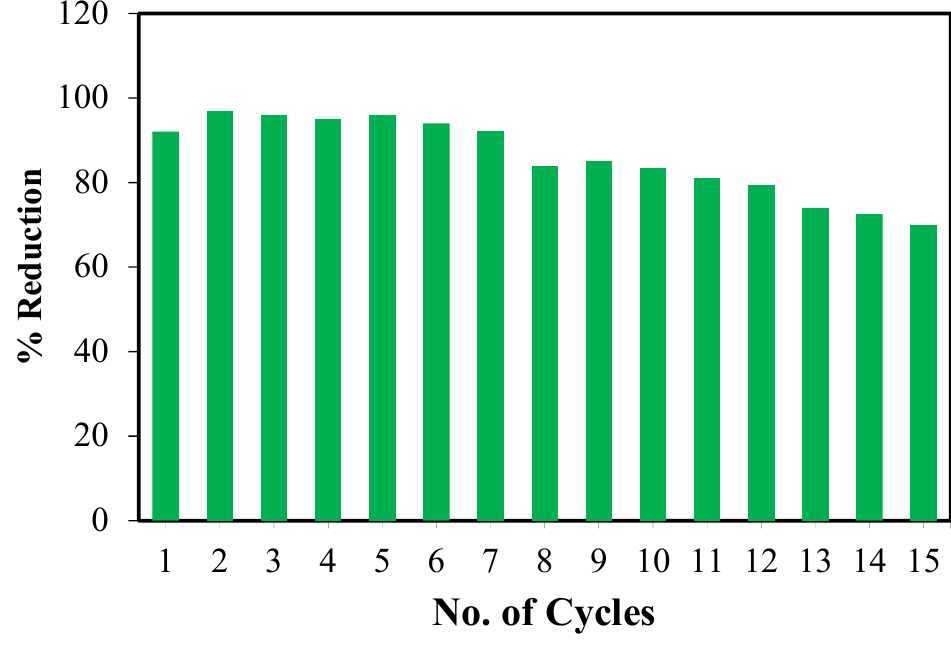
Figure 10. Reusability of ZnO/CuO/PF for reduction of Cr (VI) to Cr (III).